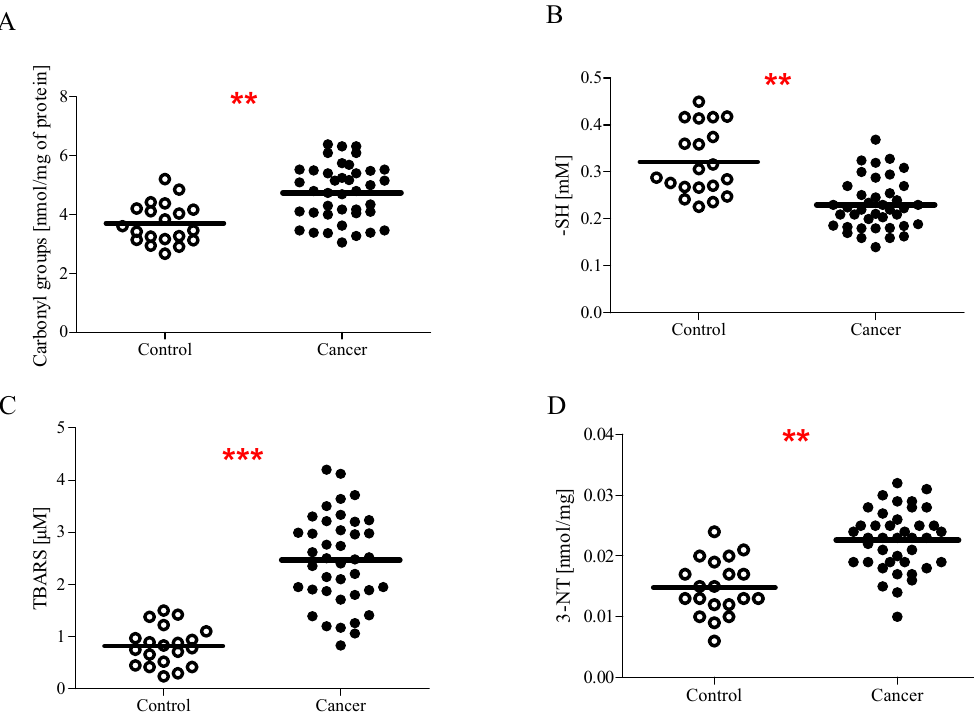
Figure 1. The level of carbonyl group ( A ), thiol groups ( B ), thiobarbituric acid reactive substances ( C ), 3-nitrotyrosine ( D ) in blood plasma proteins obtained from blood of cancer patients (n = 40) and control group (n = 20). Statistical analysis was performed using Student-t test with the correction of Cochran–Cox; ** p < 0.01, *** p < 0.001.